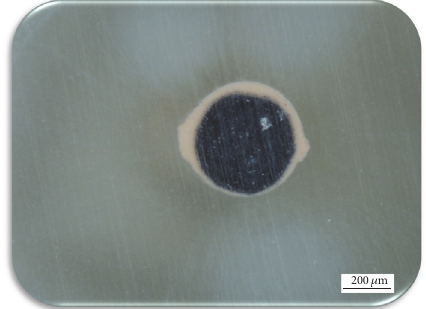
Figure 3: A representative cross section of a root canal filling using the ProTaper thermoplasticized obturator (PT Group), section A.